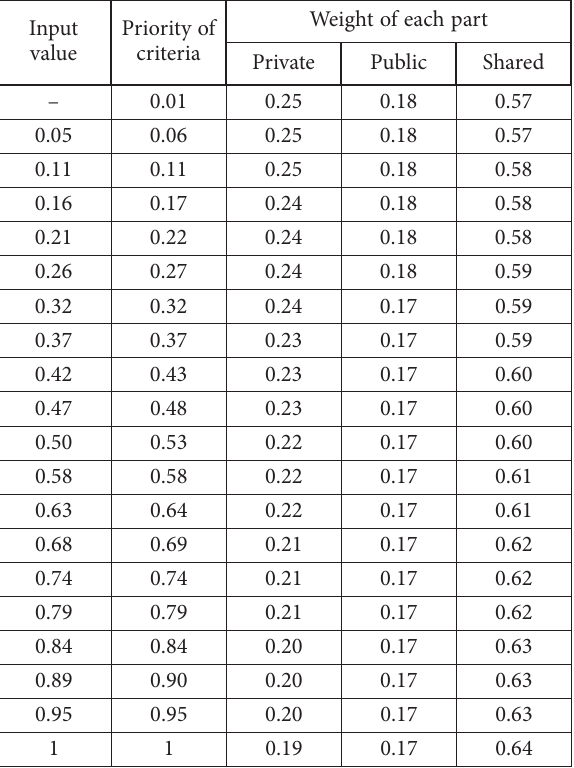
Table 13. Values to sensitivity analysis for uncertain tariff reviews risk based on criteria